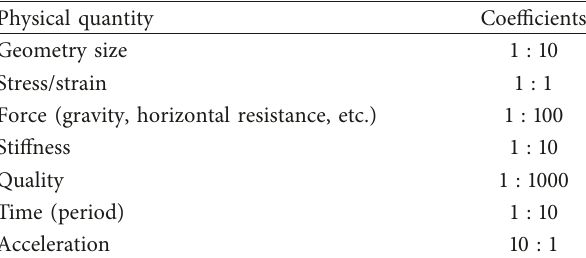
Table 1: Similarity relation of scale